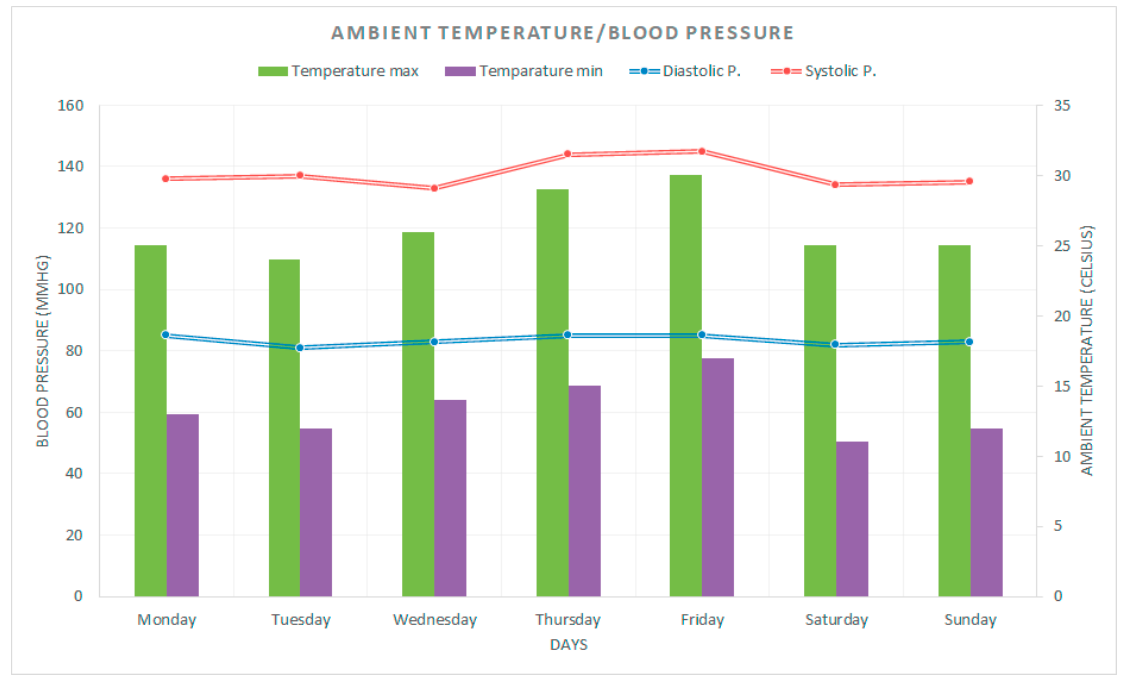
Figure 14. Blood pressure and ambient temperature measurements.